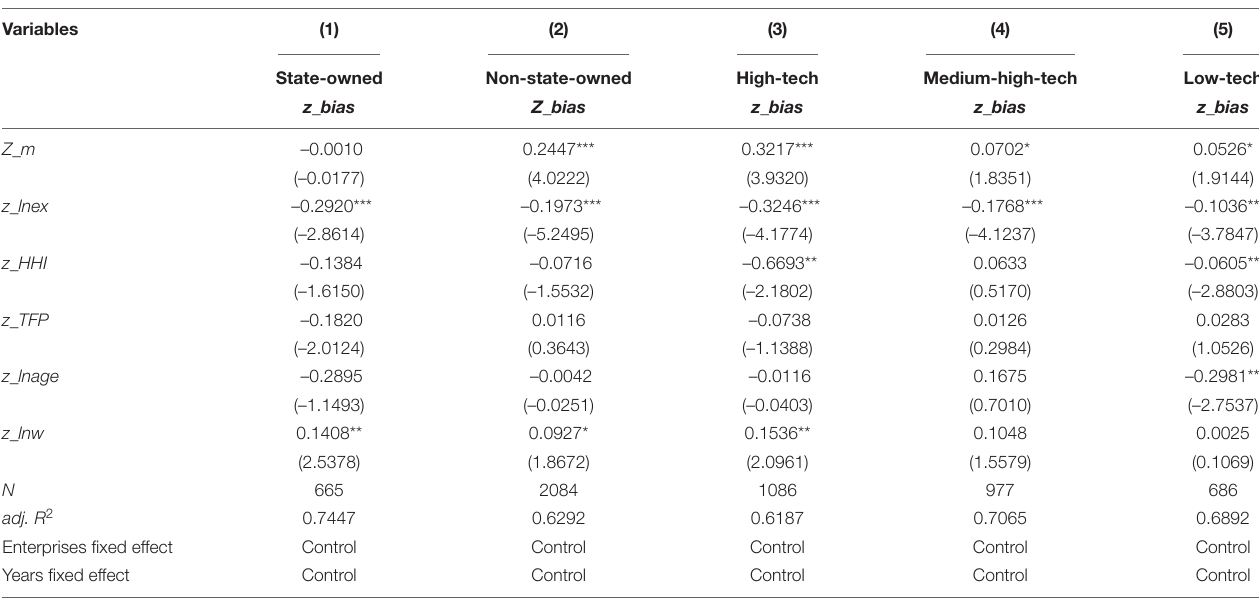
TABLE 5 | Heterogeneity